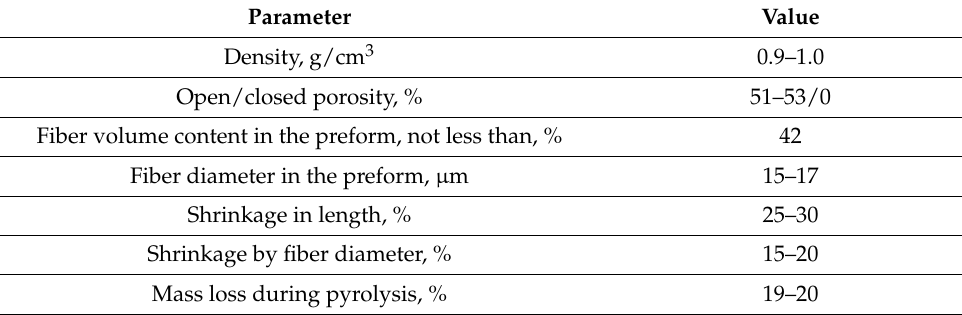
Table 1. Characteristics of the organomorphic silicon carbide preforms.